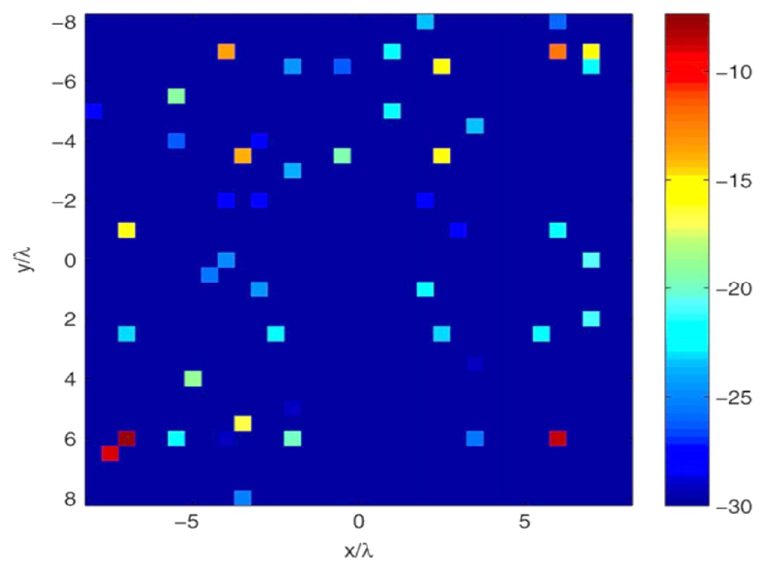
Figure 20. Reconstructed excitation error in dB by 30 random noisy measurement points.